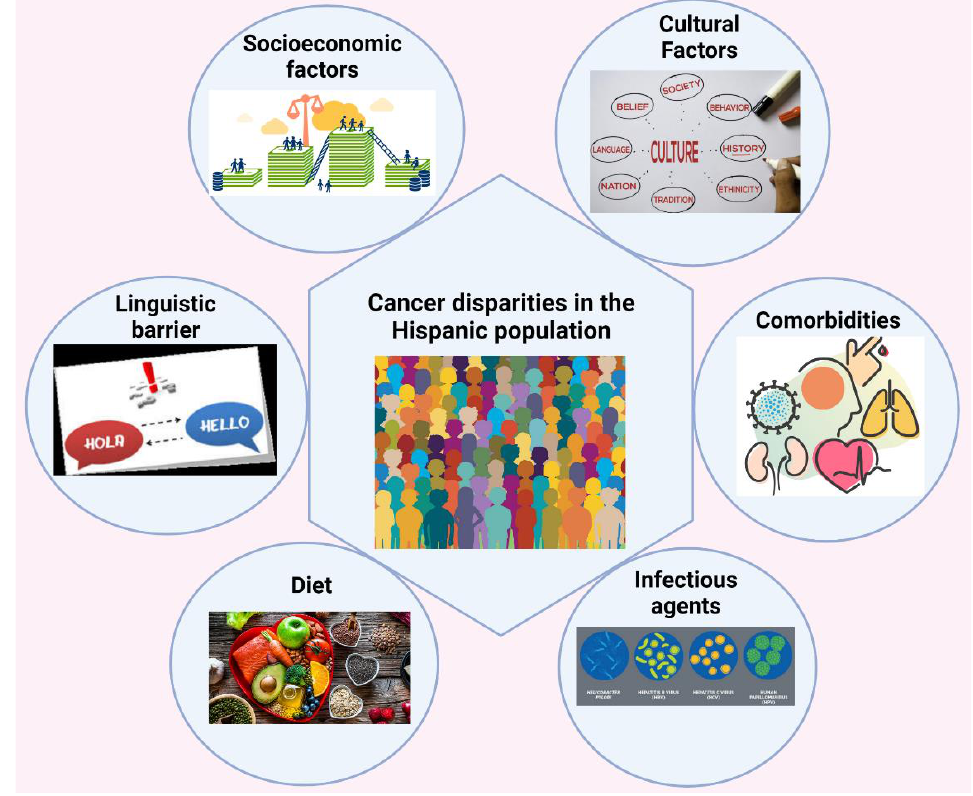
Figure 4. The possible cancer risk factors in the Hispanic ethnic group.